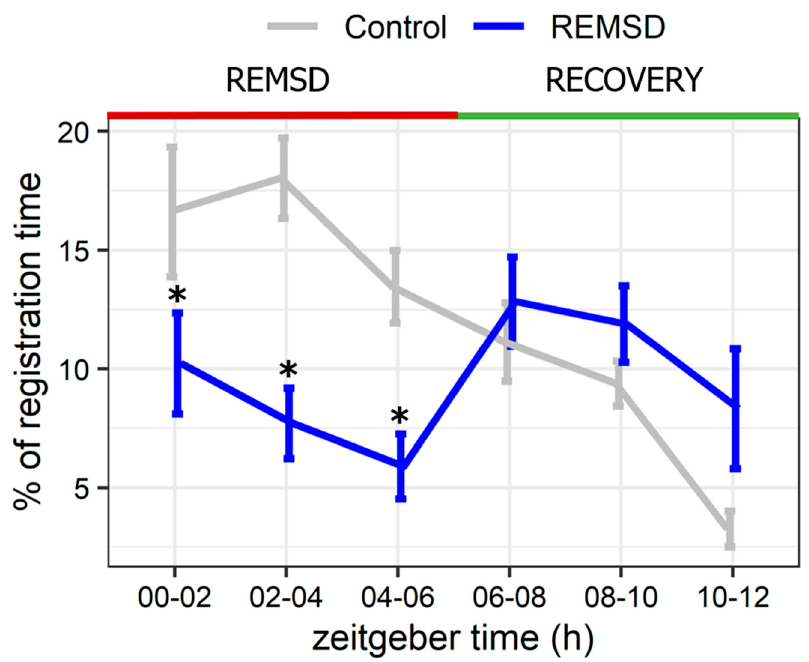
Figure 5. The reduction of deep slow-wave sleep during acute REM sleep deprivation (lights-on period, ZT00-06, REMSD) in Wistar rats without its subsequent rebound in the recovery period (ZT06-12, REC). Control—baseline recordings ( n = 5 rats). REMSD—6 h selective REM sleep deprivation using an orbital shaker ( n = 5 rats). Y-axis: % of deep SWS stage of total registration time. X-axis: zeitgeber time, h. Values are shown as mean ± s.e.m. *— p < 0.05 vs. control group, t test.